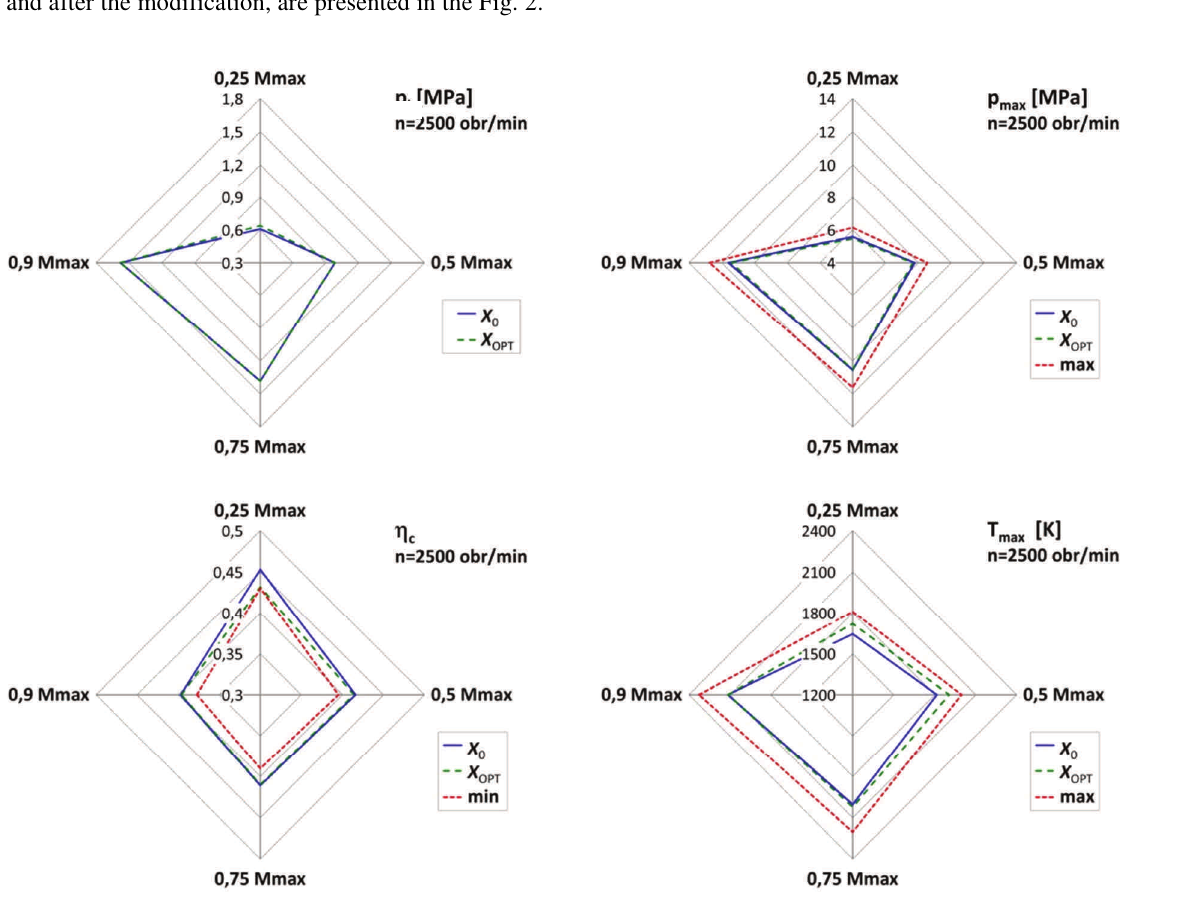
Fig. 2. Values of medium indicated pressure, thermal efficiency of working cycle, maximal pressure and temperature of the working cycle after applica- tion of calculated adjusting parameters X OPT in relation to values of factory settings X